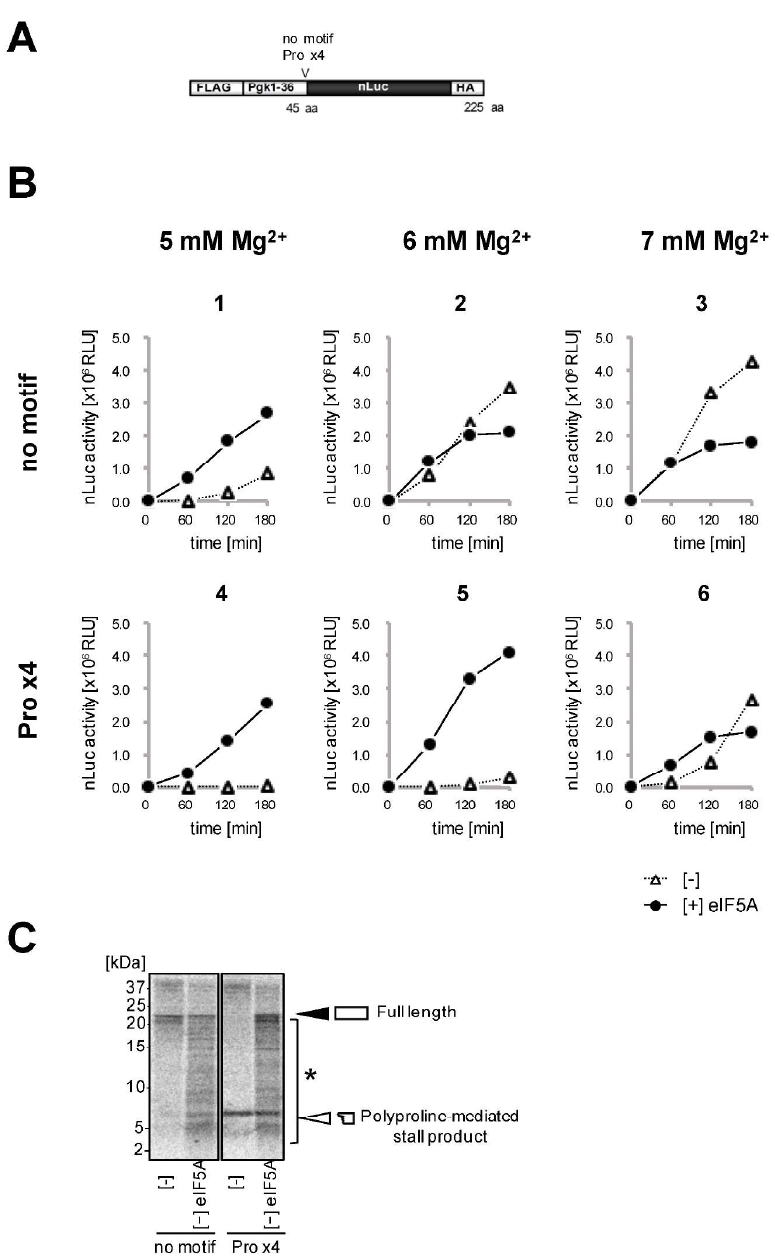
Figure 2. Analysis of translational ability of purified 80S ribosomes and determination of the appropriate Mg 2+ concentration to recapitulate the polyproline-mediated ribosomal stalling. After the purification of ribosomes, their translational abilities are checked using the indicated mRNAs (see also Table S4). Shown are the examples: ( A ) schematic of the mRNAs; ( B ) translation reactions were performed using mRNA and [ 35 S]methionine-labelled aminoacyl-tRNA mix, with 5–7 mM Mg 2+ , 0.25 mM spermidine, and 0 mM spermine. Where indicated, 0.5 µ M hypusinated eIF5A protein—equivalent to the amount of ribosomes—was included in the reaction. After incubation for the indicated time period, aliquots were subjected to nLuc assay. [-] (open triangle), no protein; [+] eIF5A (closed circle), eIF5A(hyp). ( C ) After 180-min reaction, the translation products at 6 mM Mg 2+ (Panels 2 and 5 in ( B )) were analyzed by Tricine SDS-PAGE. Black triangle, full-length product; open triangle, polyproline-mediated stall product. Asterisk indicates unknown products that are specifically produced in the presence of eIF5A, and may possibly be premature termination products (see text and [24]). For the preparation of eIF5A, see Appendix